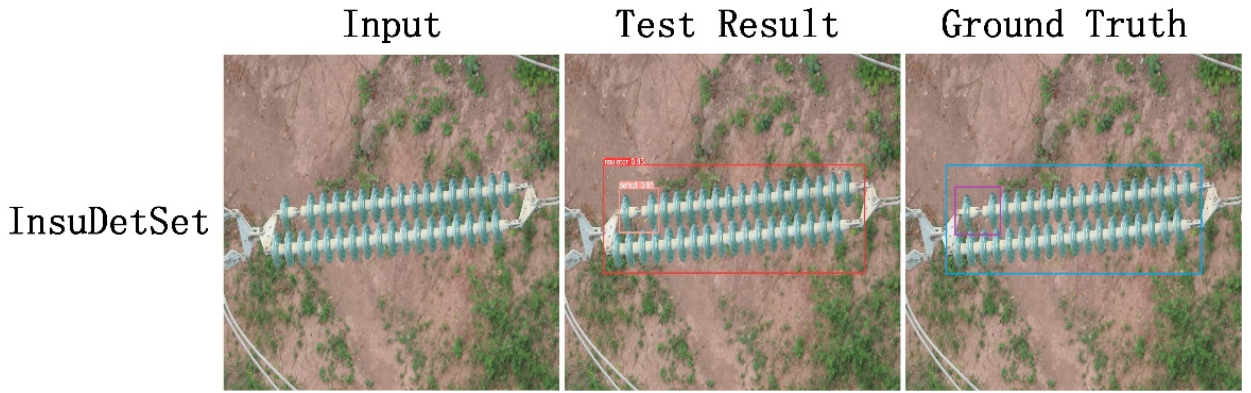
Figure 1. Test examples of our model on InsuDetSet.